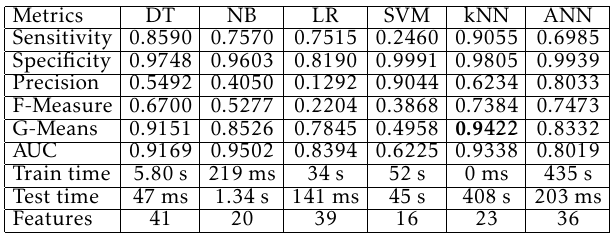
DT Table 15. Results of using IG-BFE algorithm on